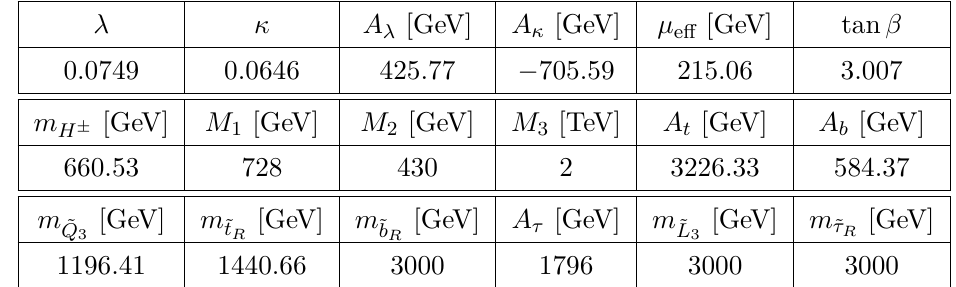
Table 19 . BP11: NMSSM input parameters required by NMSSMCALC for the computation of the NMSSM